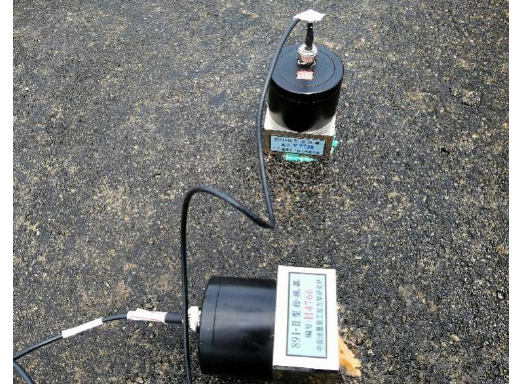
Figure 8. Displacement sensor.